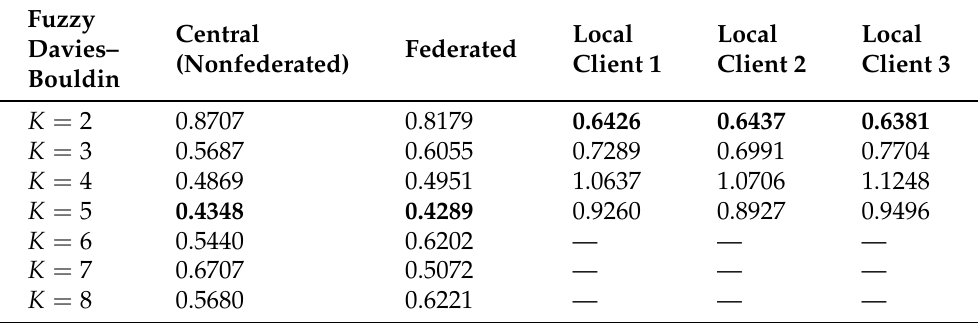
Table 1. Local and federated clustering results on the motivational dataset with k -means averaging. The best result per experiment (column) is